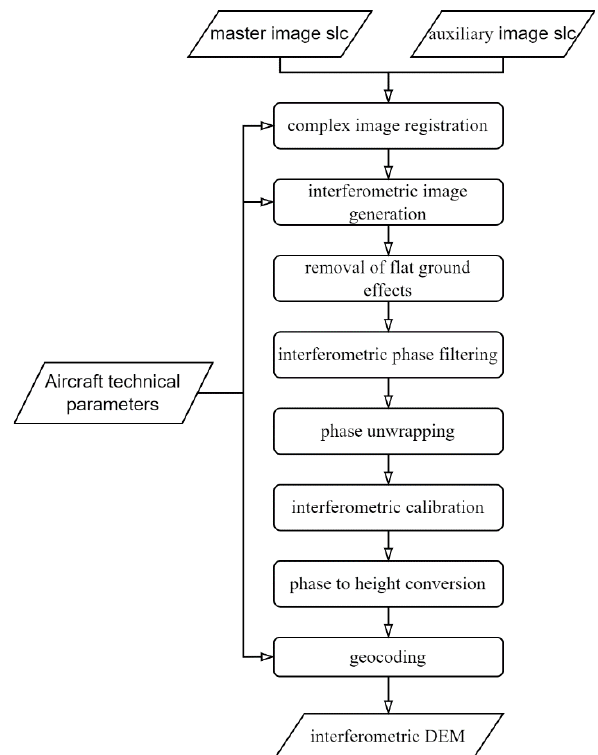
Figure 3 . Diagram illustrates the DEM extraction